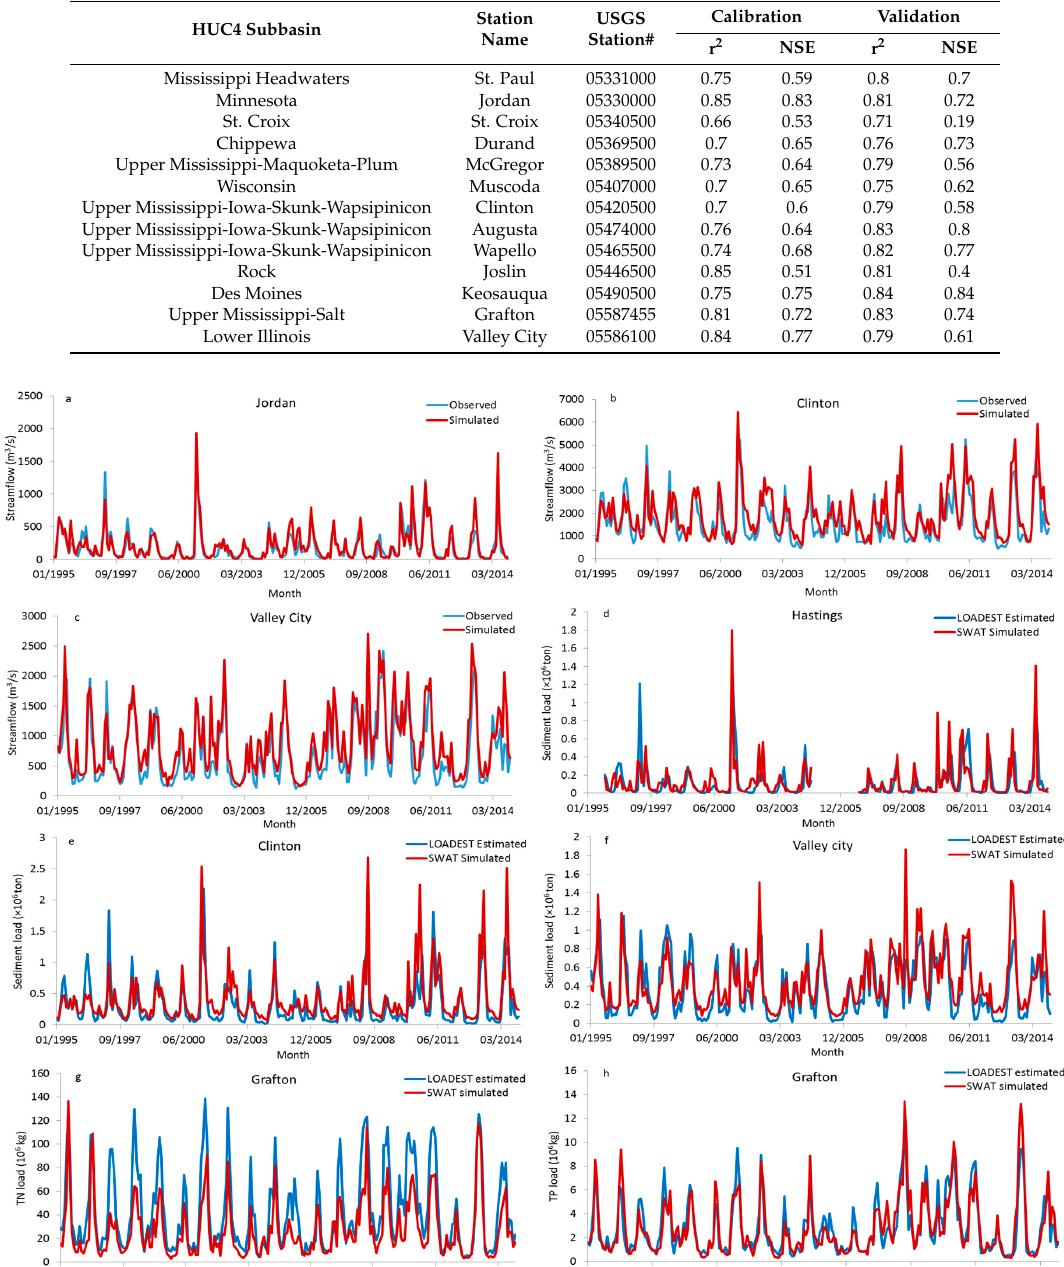
Monthly streamflow calibrated stations and statistical results in the UMRB. USGS, US Geological Survey; NSE, Nash-Sutcliffe efficiency.